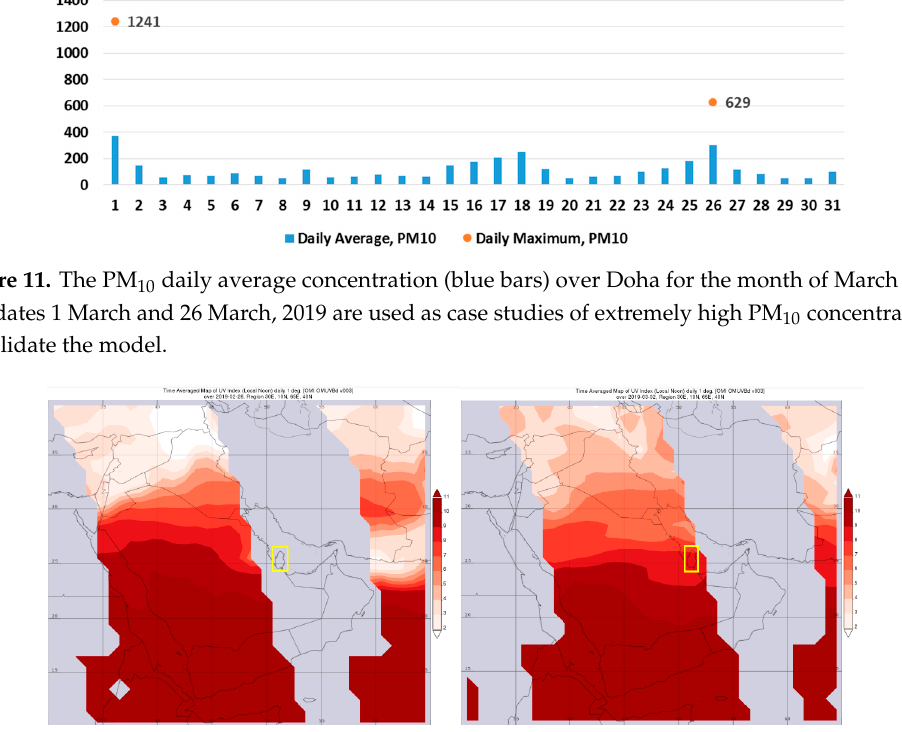
Figure 12. OMI Aura UVI plots for the Arabian Peninsula on (left) 28 February, 2019, and on 2 (right) March, 2019 generated using NASA’s GIOVANNI platform. All data that are greyed out are from where the satellite did not pass over and thus did not have UVI information. Qatar is highlighted in a yellow box.